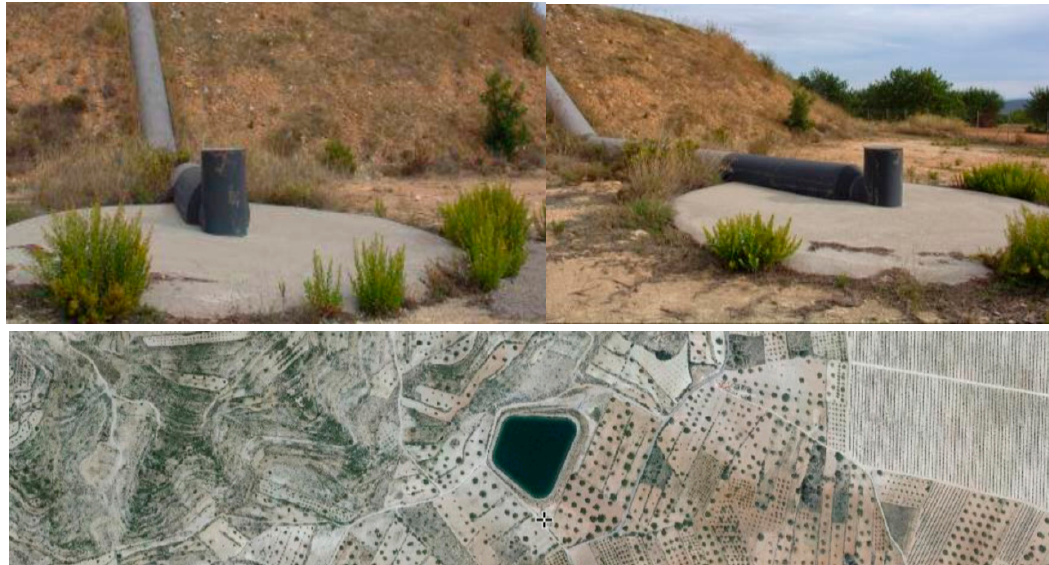
Figure 9. Deep borehole “Arnachos” at Balsa del Campo, Valencia (UTM 685,744 / 4,391,256) located in the margin of an irrigation pond and used as both, a safety and recharge element. Photos courtesy of J.M. Montes and FEGA.